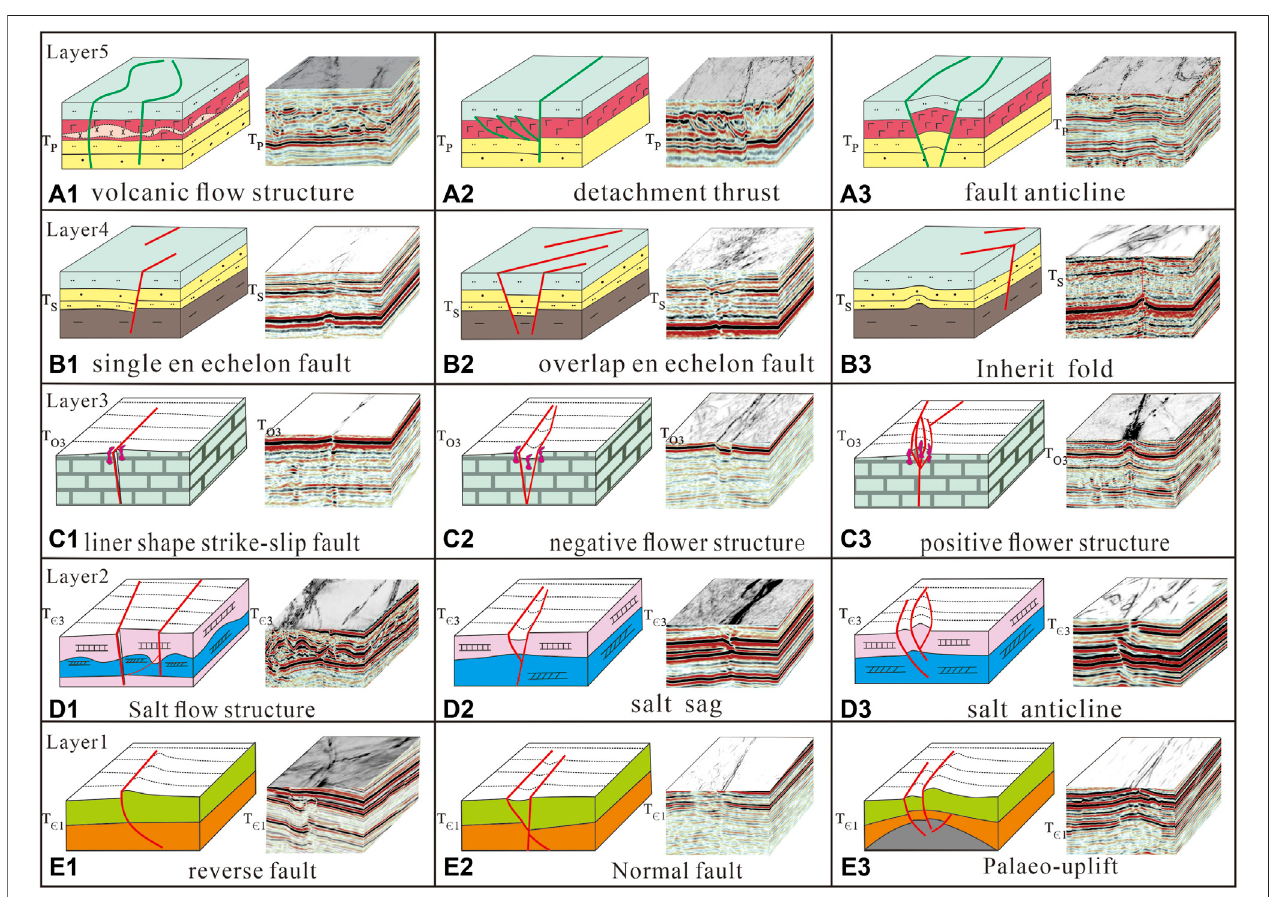
FIGURE 7 | Styles of layered deformation of strike-slip fault systems: (A1 – A3) Permian volcanic rock deformation layer, (B1 – B3) Upper Ordovician – Silurian clastic rock deformation layer, (C1 – C3) Upper Cambrian – middle Ordovician carbonate rock deformation layer, (D1 – D3) Middle Cambrian salt-related deformation layer, and (E1 – E3) Sinian – Lower Cambrian deformation